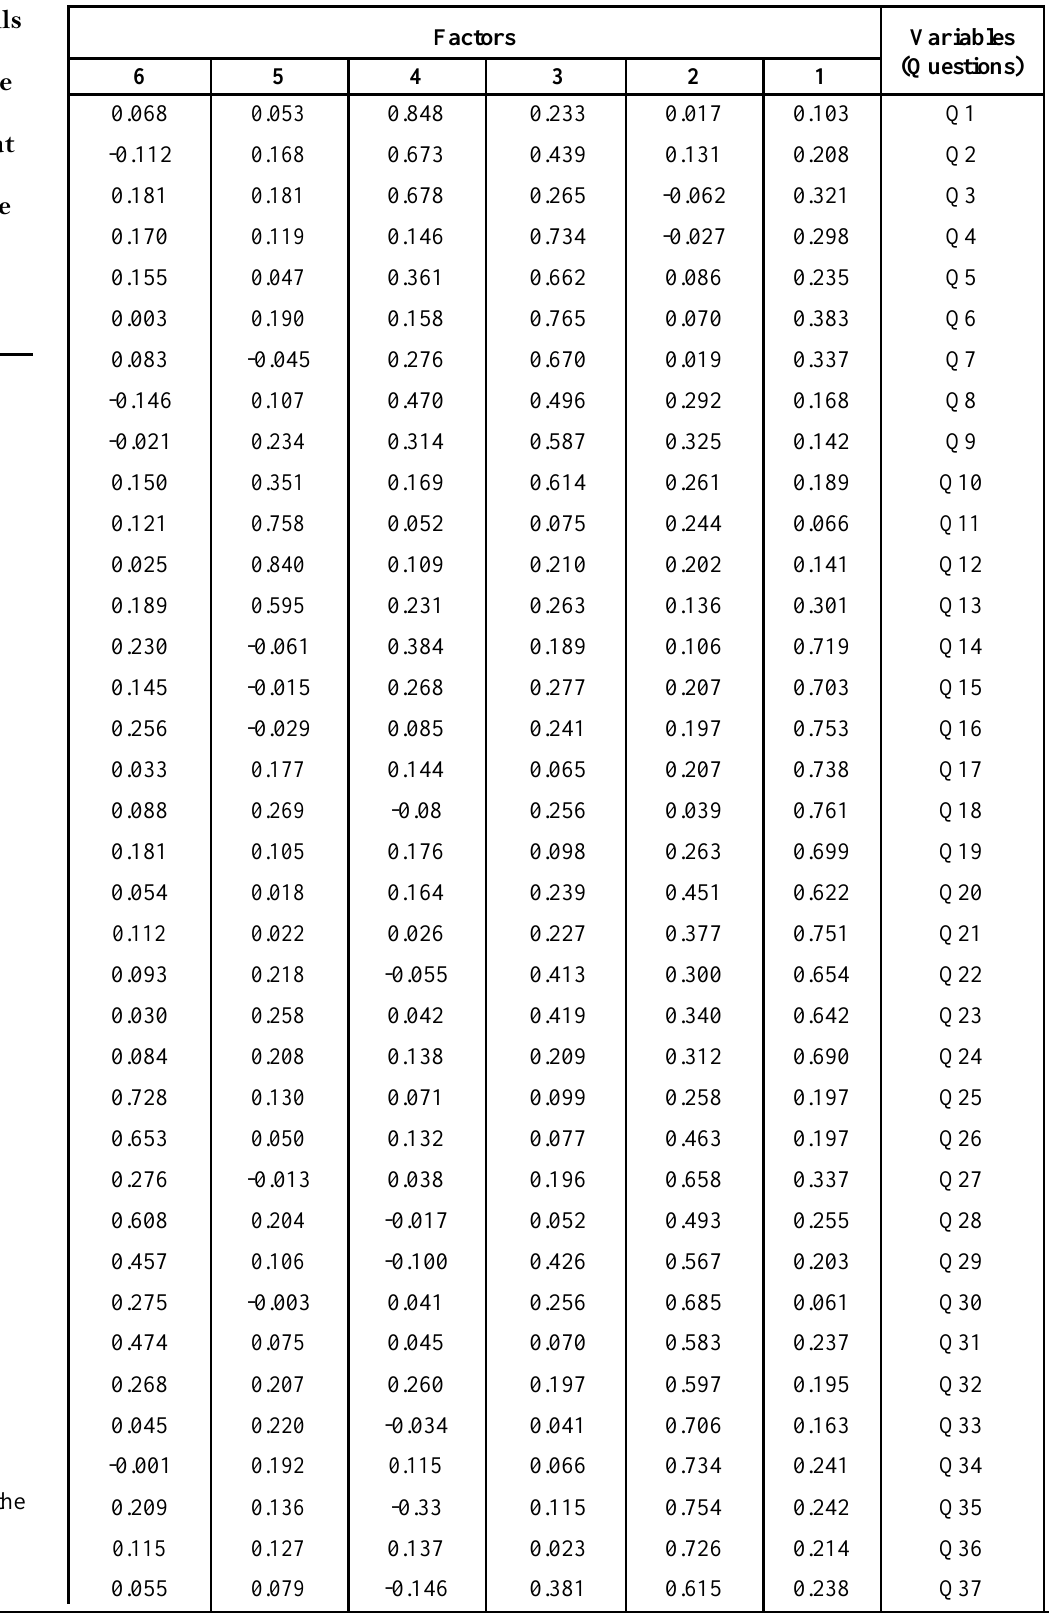
Table 7. Rotated matrices of the factors and their related factor